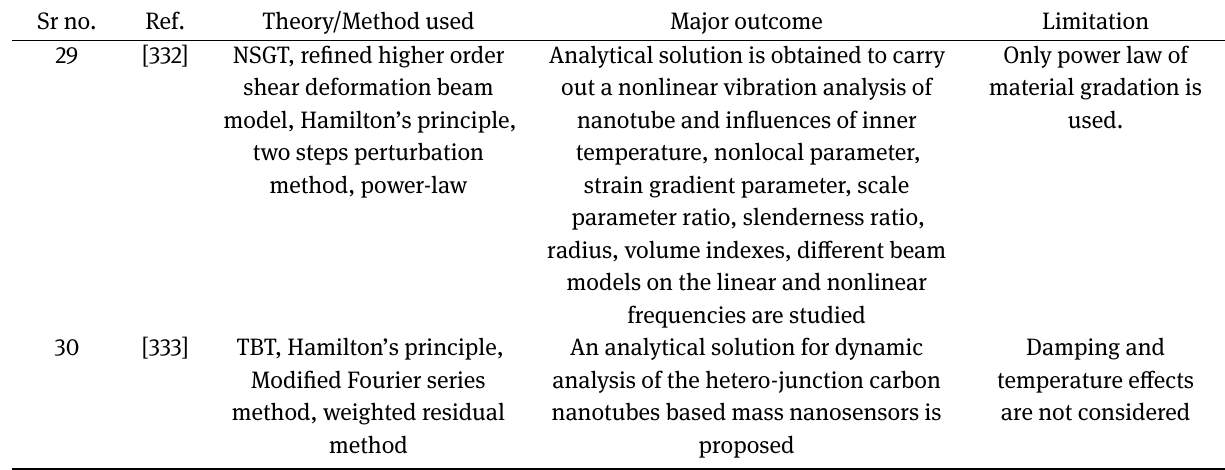
Table 4: ...continued Sr